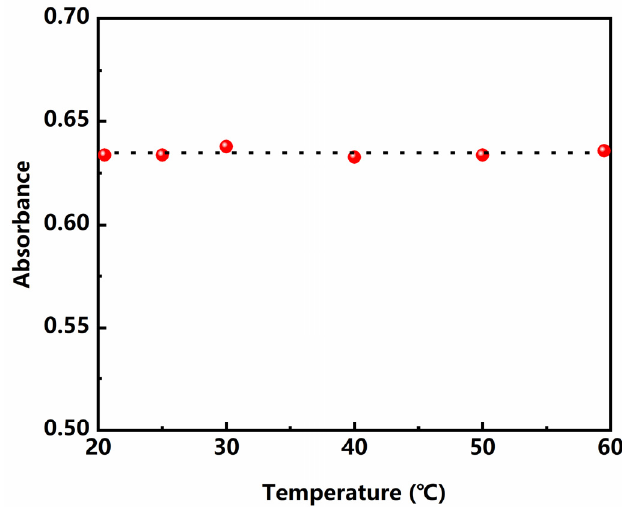
Figure 6. Effect of temperature on the absorbance.